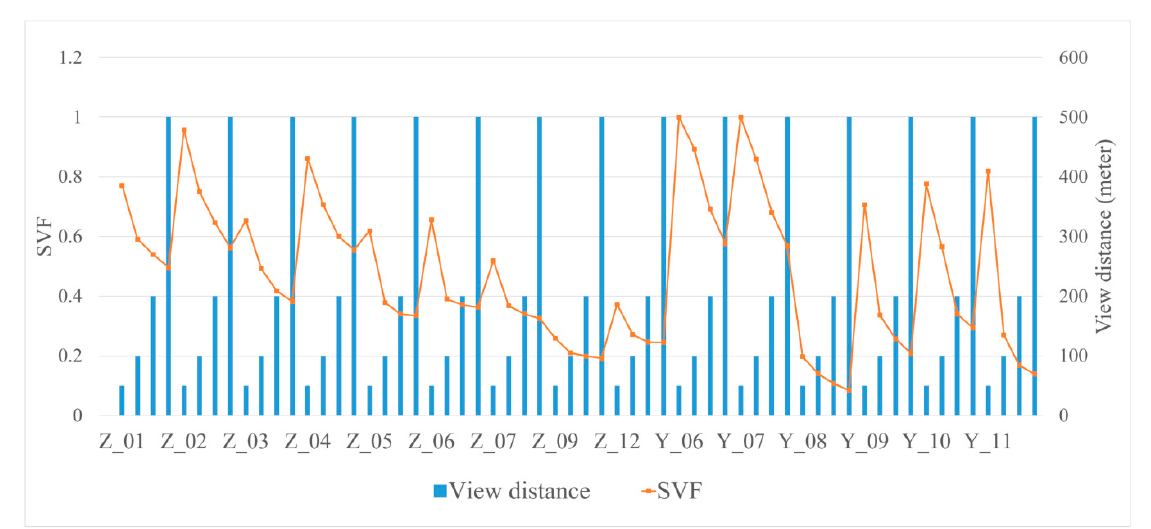
Figure 7. Diagram of sky view factor (SVF).